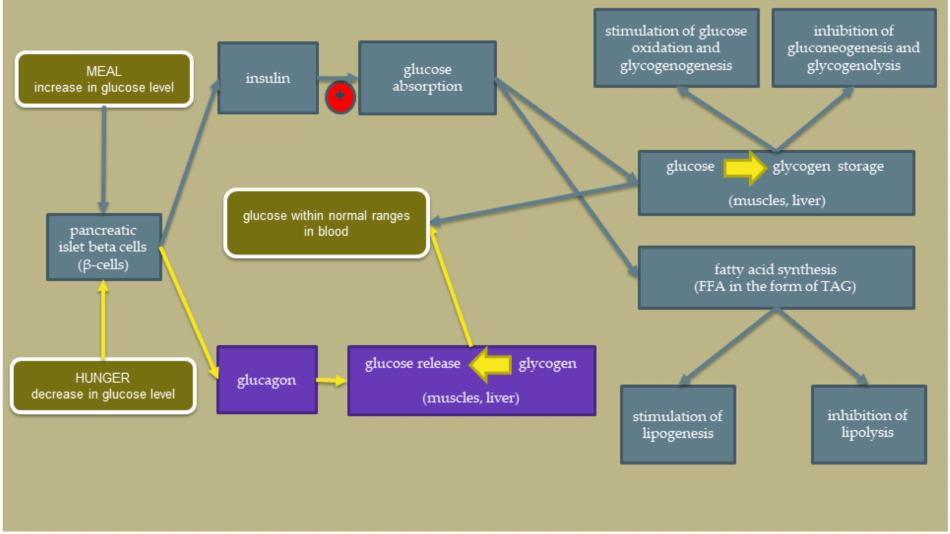
Figure 1. The insulin action is in a healthy state. (FFA—free fatty acids;